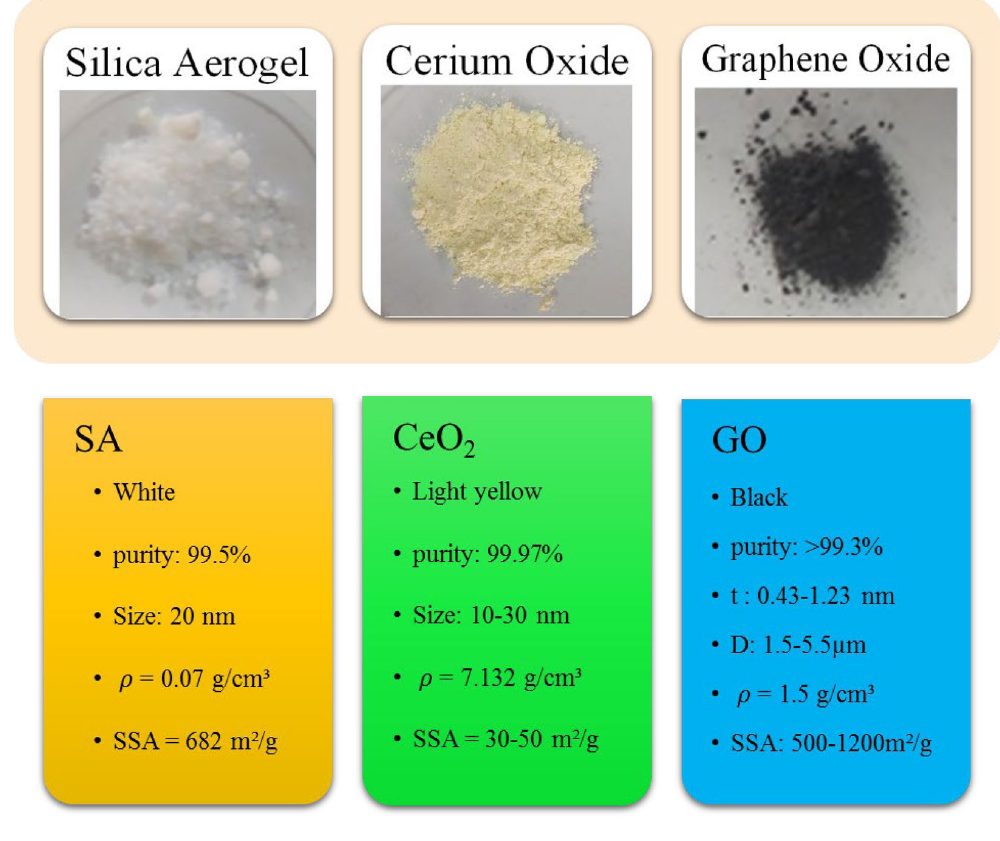
Figure 1. The characteristics of the used